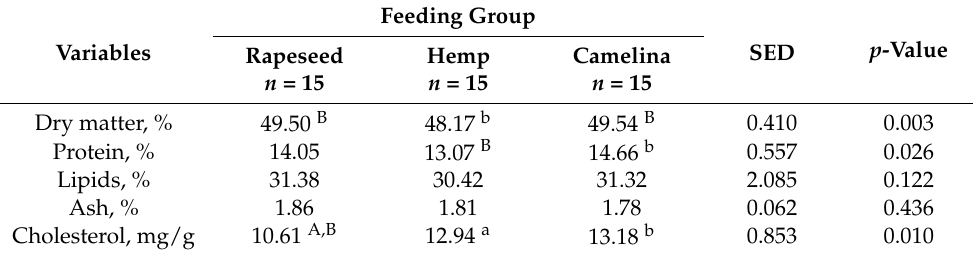
Table 5. Effects of diet on egg yolk proximate composition and cholesterol content in different quail